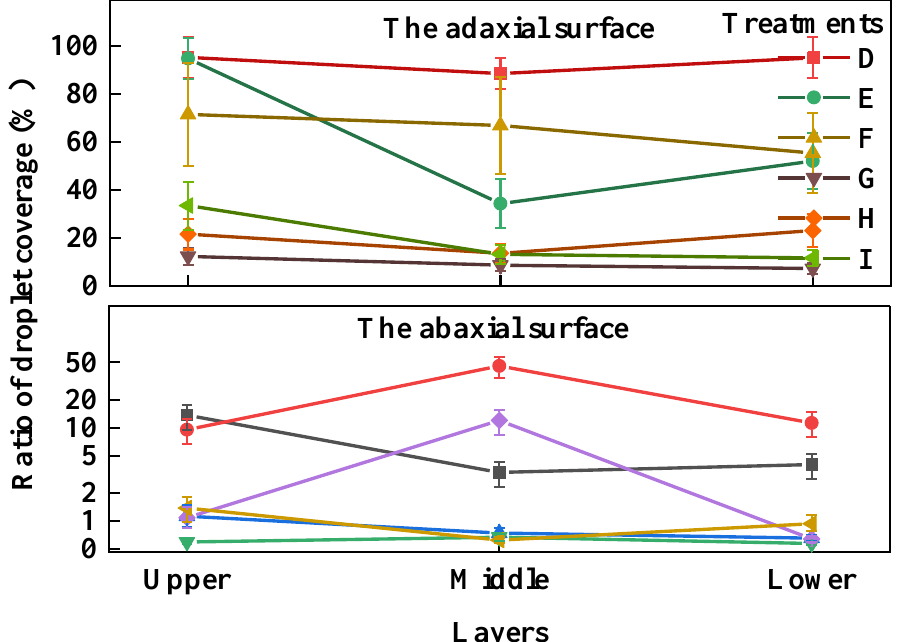
Figure 8. The ratio of droplet coverage distribution of using the boom sprayer with the canopy- opening device.